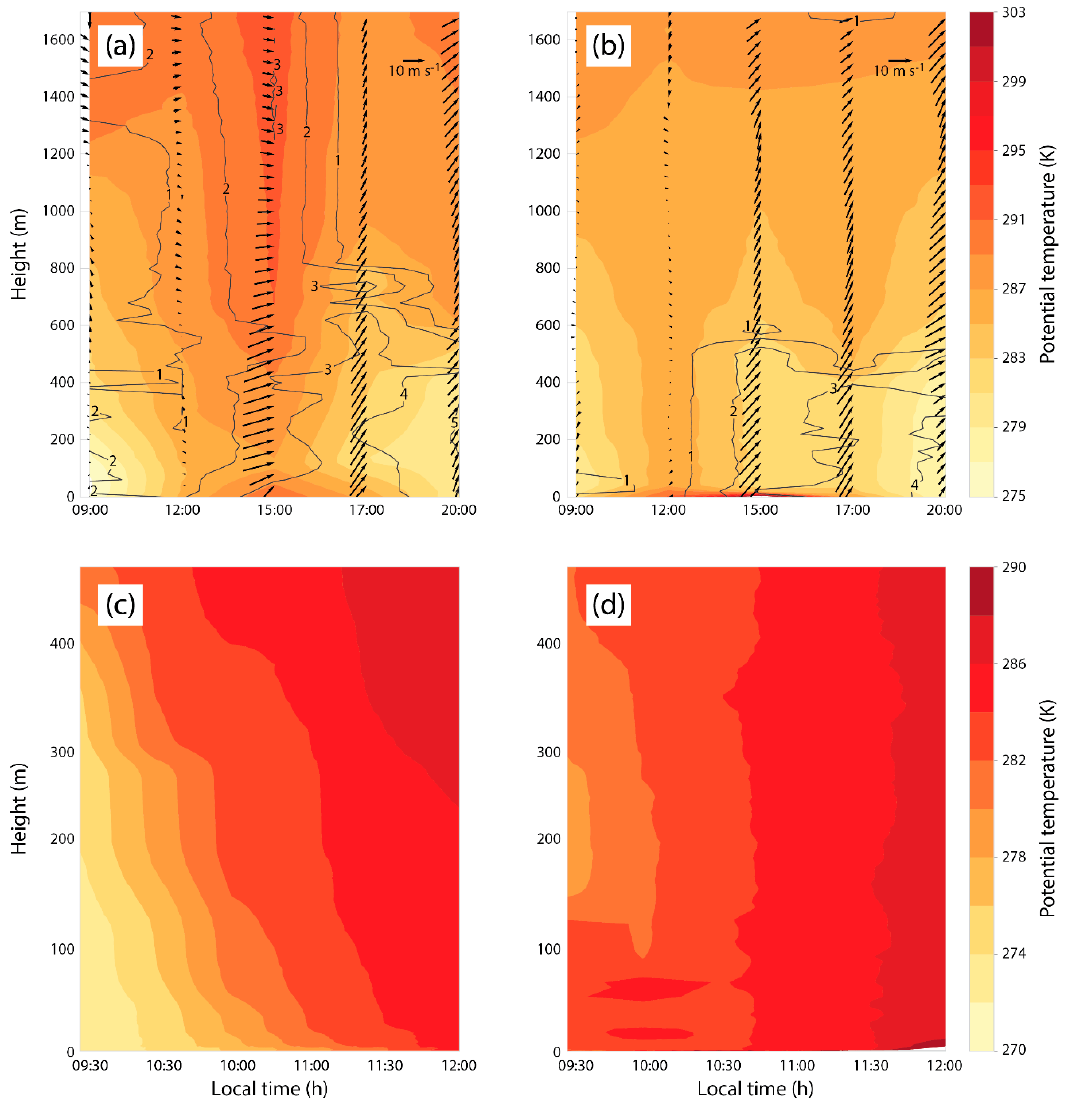
Figure 7. Diurnal evolution of the vertical profiles of potential temperature (K, colors), specific humidity (g kg − 1 , solid lines) and horizontal wind speed and wind direction (m s − 1 , arrows) measured with the radiosoundings. Measurements performed on 21 November 2018 above the saline lake ( a ) and on 22 November 2018 above the desert ( b ). Conventional directions and arrow lengths are shown at the top of panels ( a ) and ( b ). Morning evolution of the potential temperature measured with the UAV on 21 November 2018 above the saline lake ( c ) and on 22 November 2018 above the desert ( d ). Note the di ff erent height and temperature scales between the radiosondes and UAV data.